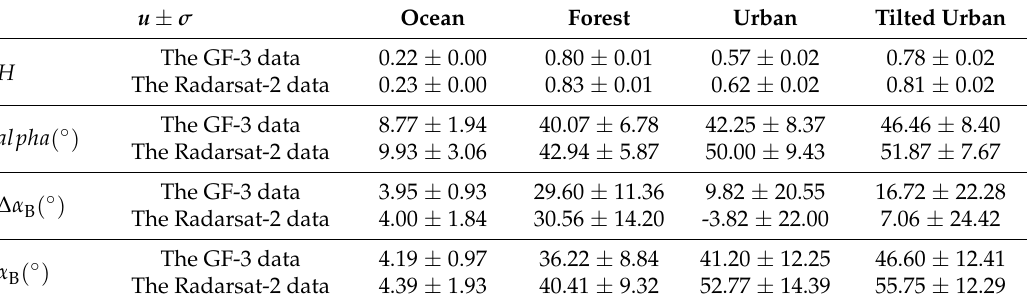
Table 2. The averaged values of different parameters of the four selected typical theme areas, where u denotes the averaged value and σ denotes the standard deviation.